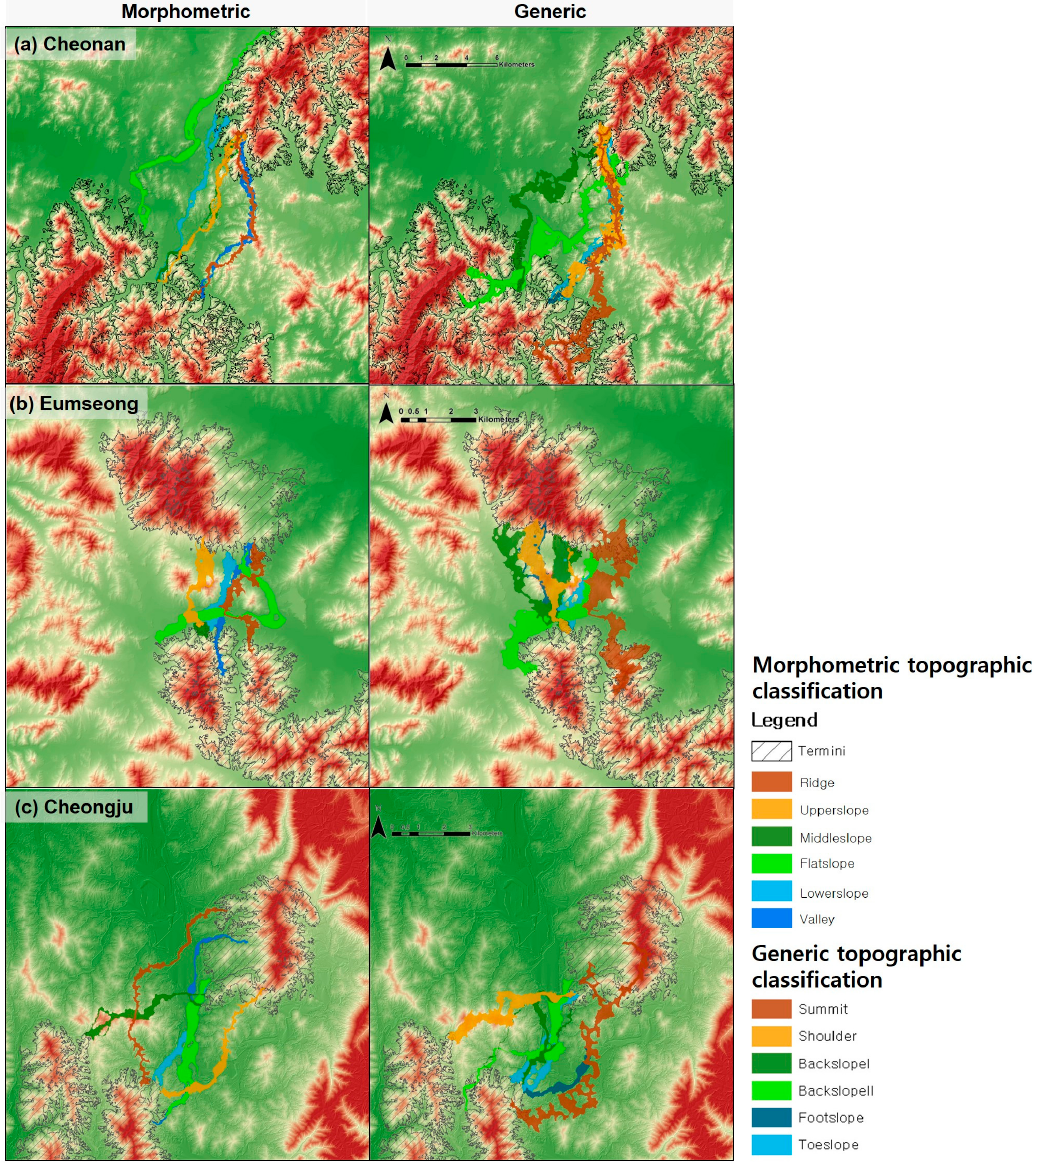
Figure 7. Topographic linkages based on morphometric and generic topographic classification.